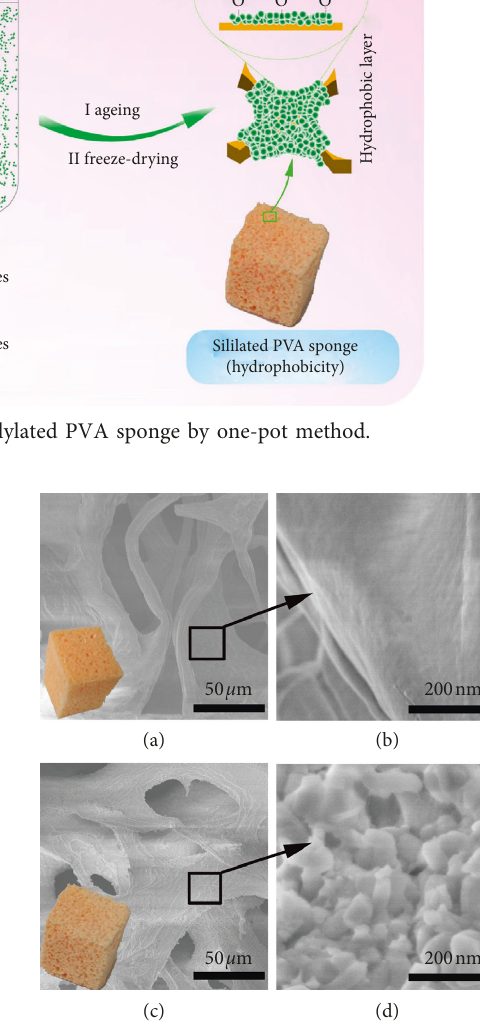
Figure 3: SEM images with different magnifications for pure PVA sponge (a, b) and the silylated PVA sponge (c, d). Insets are their corresponding digital